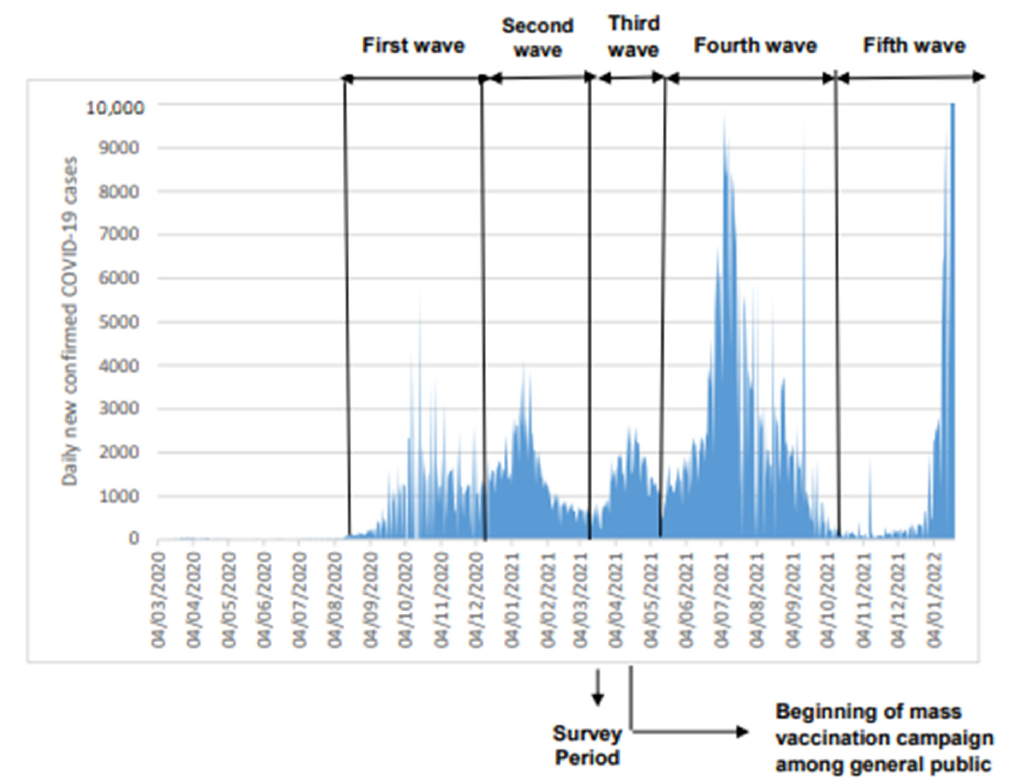
Figure 1. Epidemic curve COVID-19 cases in Tunisia expressed as daily new confirmed cases (Data source: [16]).